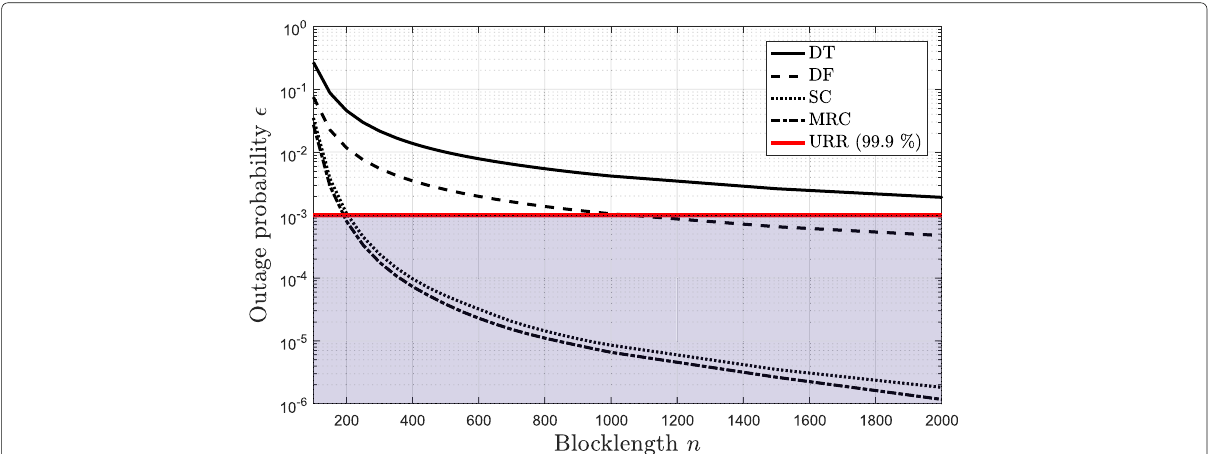
Fig. 7 Outage probability analysis for DT, DF, SC, and MRC under EPA. This figure compares the performance of cooperative schemes to direct transmission in terms of outage probability under the finite blocklength regime. We indicate that URLLC is feasible via cooperative diversity technique. We show the superiority of MRC and SC over DF and DT schemes under the finite blocklength regime